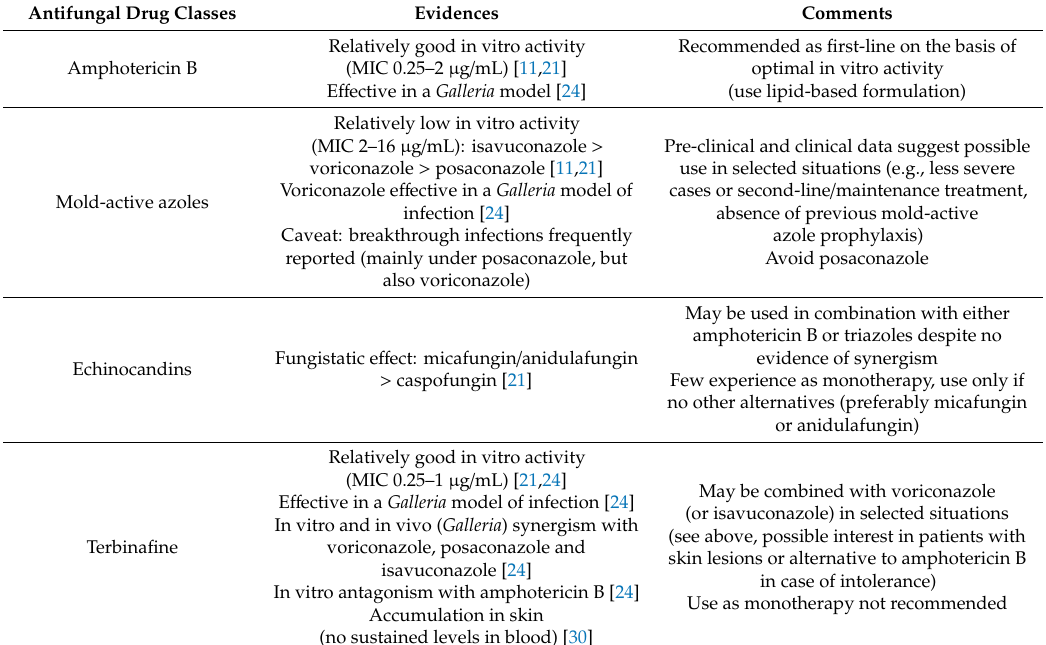
Table 2. Current antifungal therapeutic options against Aspergillus calidoustus and other Aspergillus spp. of section